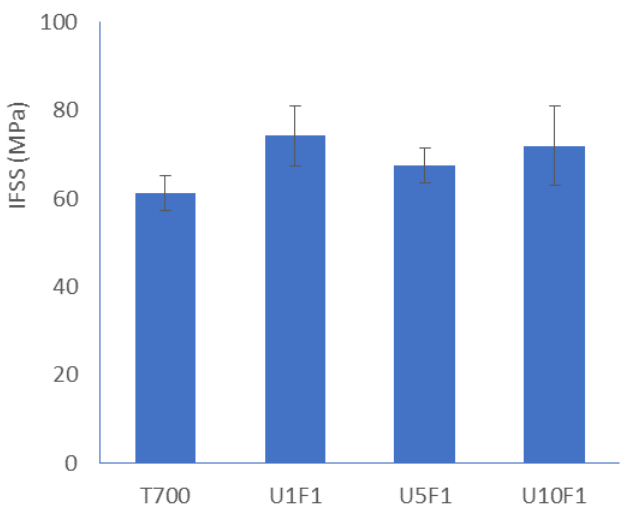
Figure 11. Comparison of the interfacial shear strength with different specimen thickness of the sized carbon fibres in CFRP.